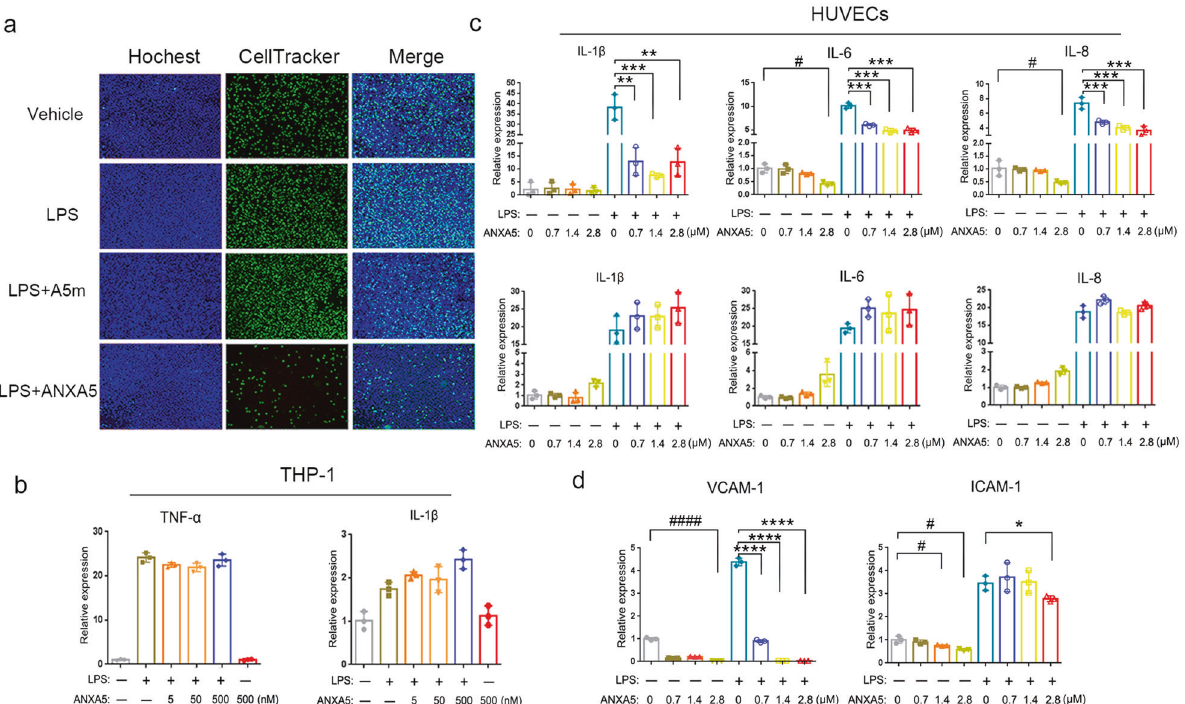
Fig. 6 ANXA5 inhibits monocyte-endothelial cell adhesion and HUVECs activation. a Representative images of monocyte (THP-1) adhesion to endothelial cell (HUVEC). HUVECs were pretreated with LPS (0.2 μ g/ml) or ANXA5/A5m (250 nM) as indicated, and then incubated with THP-1 cells (labeled with CellTracker in green). Hoechst staining for total cells. b THP-1 cells were induced by LPS (10 ng/ml) and treated with ANXA5 (0 – 500 nM). TNF- α and IL-1 β mRNA were detected by qRT-PCR. c HUVECs were activated by LPS (1 μ g/ml) and treated with ANXA5 or A5m at different doses. The levels of cytokines (IL-1 β , IL-8, and IL-6) were analyzed by qRT-PCR. d The levels of ICAM-1 and VCAM-1 mRNA in LPS- activated HUVECs treated with ANXA5. All data are presented as mean ± SD representative of three independent experiments. * P < 0.05, ** P < 0.01, *** P < 0.001, **** P < 0.0001, # P < 0.05, #### P < 0.0001 versus the corresponding control group according to Student ’ s t